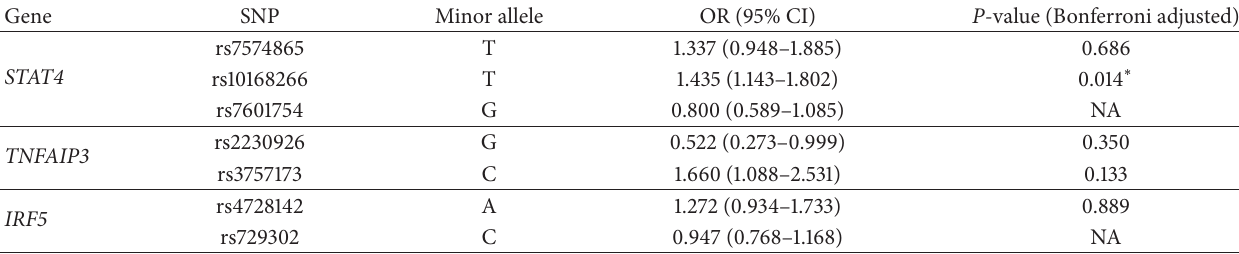
Table 5: Association of each SNP with the Malaysian SLE, resulting from combined analysis of the three